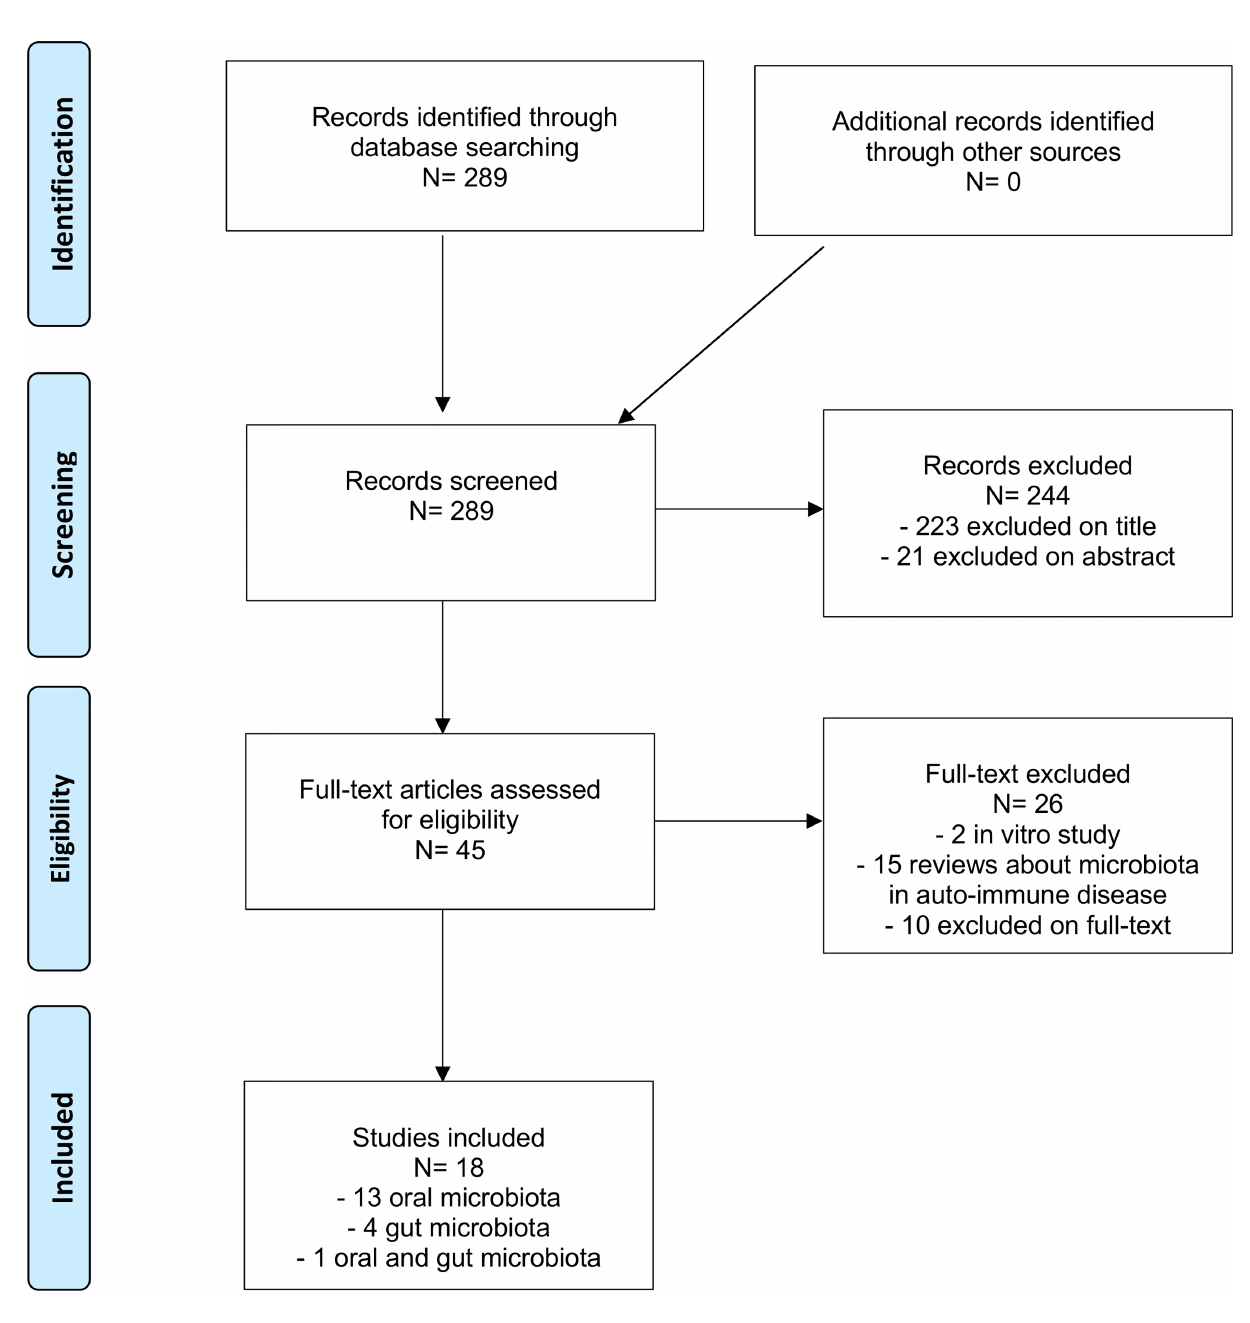
FIGURE 1 | Flow-chart diagram of the selection